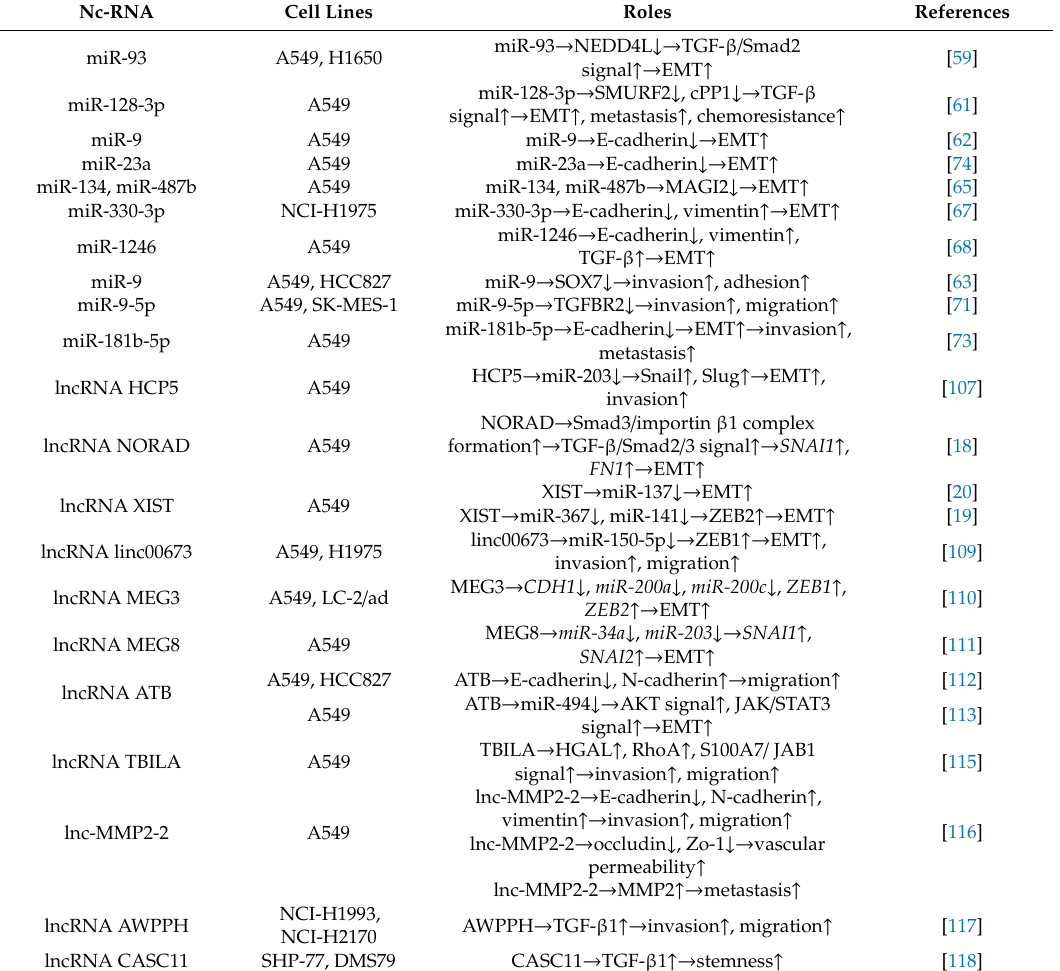
Abbreviations: nc-RNA, non-coding RNA; miR, microRNA; NEDD4L, Neural precursor cell expressed developmentally downregulated gene 4-like; TGF- β , transforming growth factor- β ; EMT, epithelial-mesenchymal transition; SMURF2, Smad ubiquitin regulatory factor 2; cPP1, catalytic subunit of protein phosphatase 1; MAGI2, membrane-associated guanylate kinase, WW and PDZ domain-containing protein 2; SOX7, SRY-Box 7; TGFBR2, TGF- β receptor 2; lncRNA, long non-coding RNA; HCP5, histocompatibility leukocyte antigen complex P5; XIST, X inactivate-specific transcript; ZEB2, Zinc finger E-box-binding homeobox 2; lncRNA-ATB, lncRNA activated by TGF- β ; AKT, protein kinase B; JAK, Janus-activated kinase; STAT3, signal transducer and activator of transcription-3; TBILA, TGF- β -induced lncRNA; HGAL, human germinal center-associated lymphoma; JAB1, c-Jun activation domain-binding protein 1; Zo-1, zonula occludens-1; MMP2, matrix metalloprotease